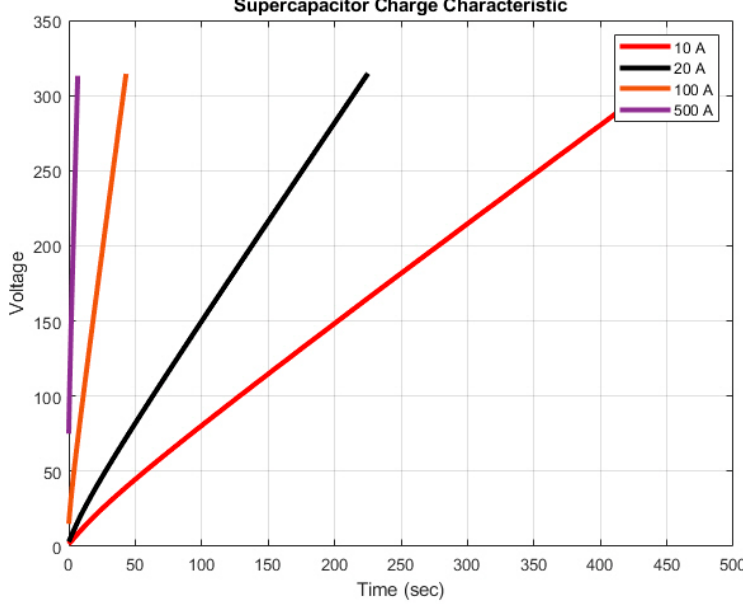
Figure 11. Characteristics of the supercapacitor charge.